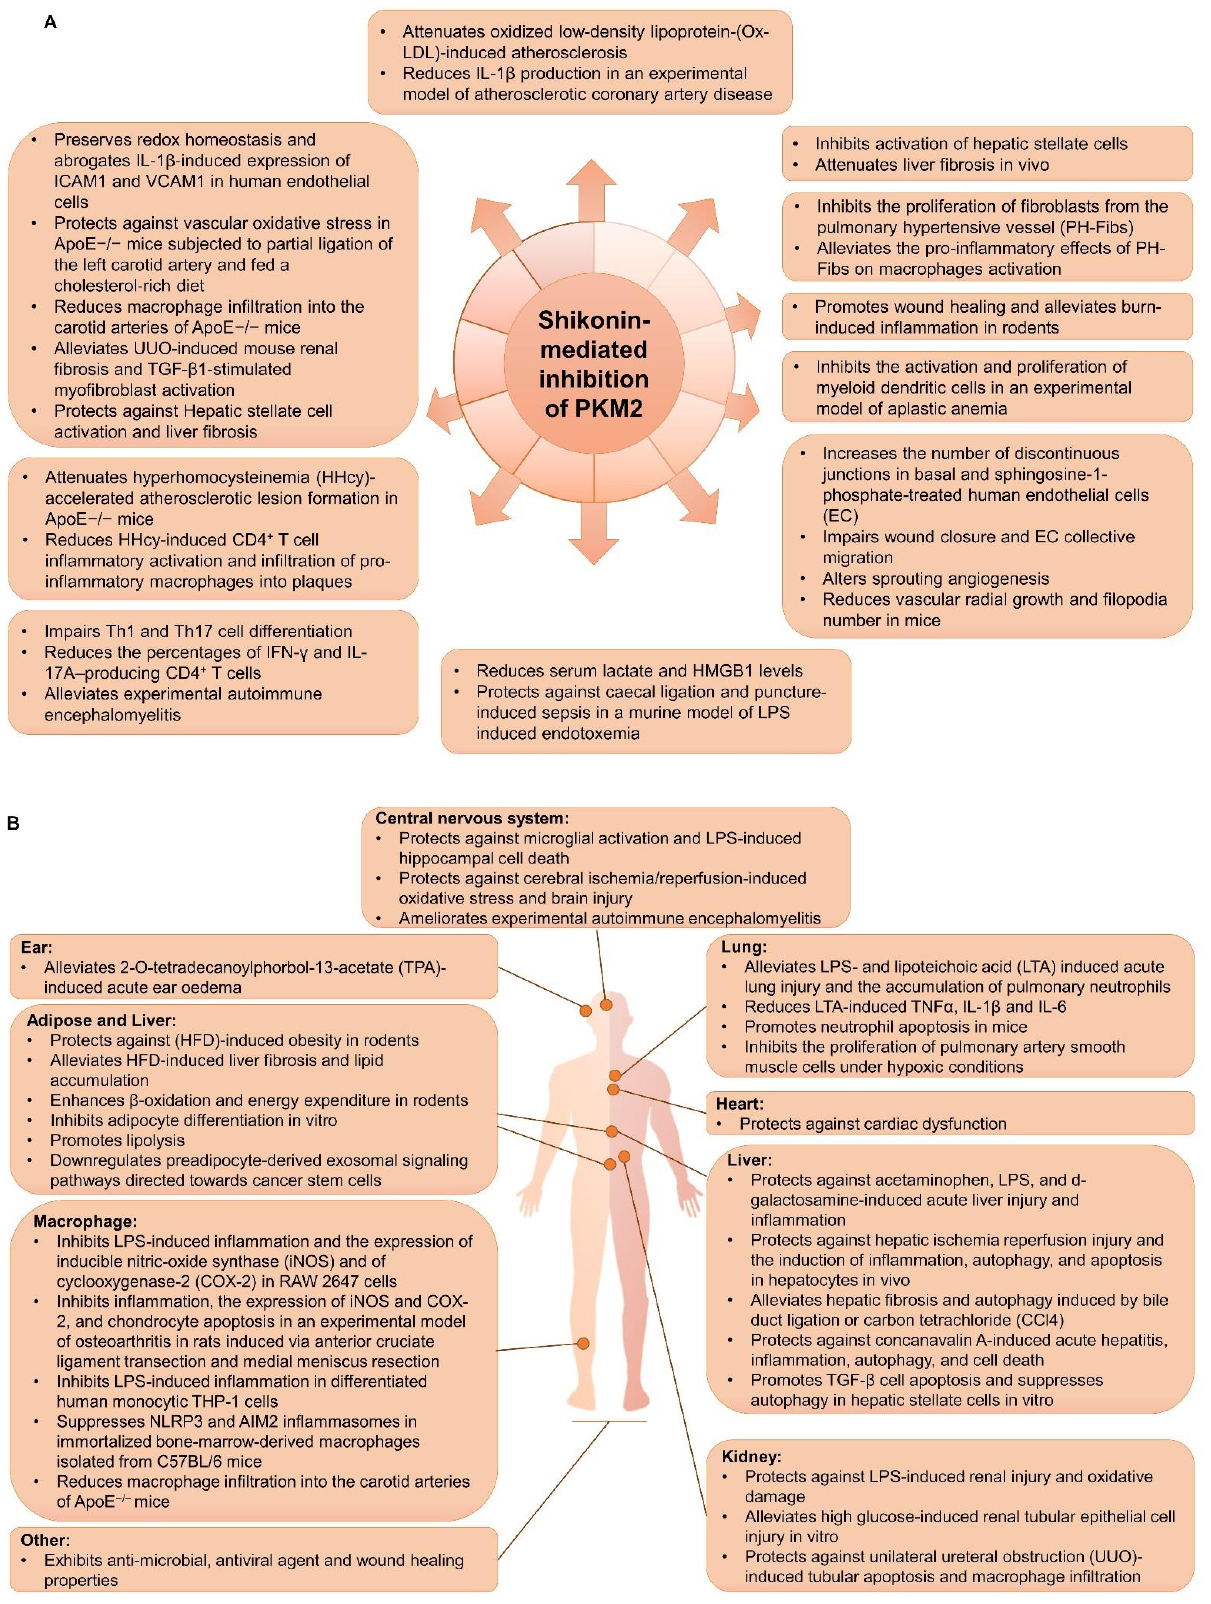
Figure 4. Effects of shikonin-mediated inhibition of PKM2 ( A ) and some other reported effects ( B ) not necessarily linked to PKM2.